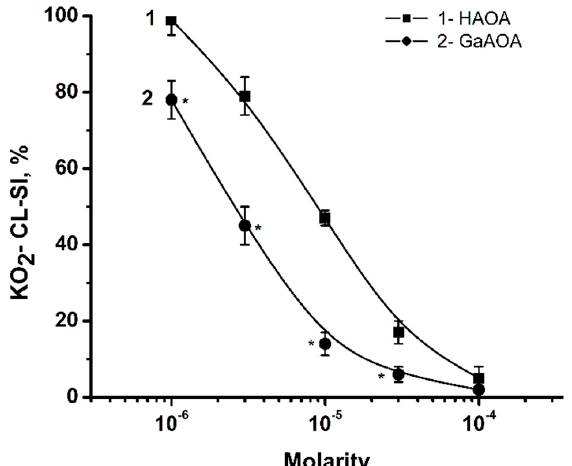
Figure 1. Effect of 5-aminoorotic acid (HAOA) (curve 1) and gallium(III) 5-aminoorotate (GaAOA) (curve 2) on luminol-dependent chemiluminescence (LDCL) in the presence of KO 2 -generated superoxide radical. Data = mean ± SD ( n = 5). *, statistically significant difference from HAOA ( p < 0.05).